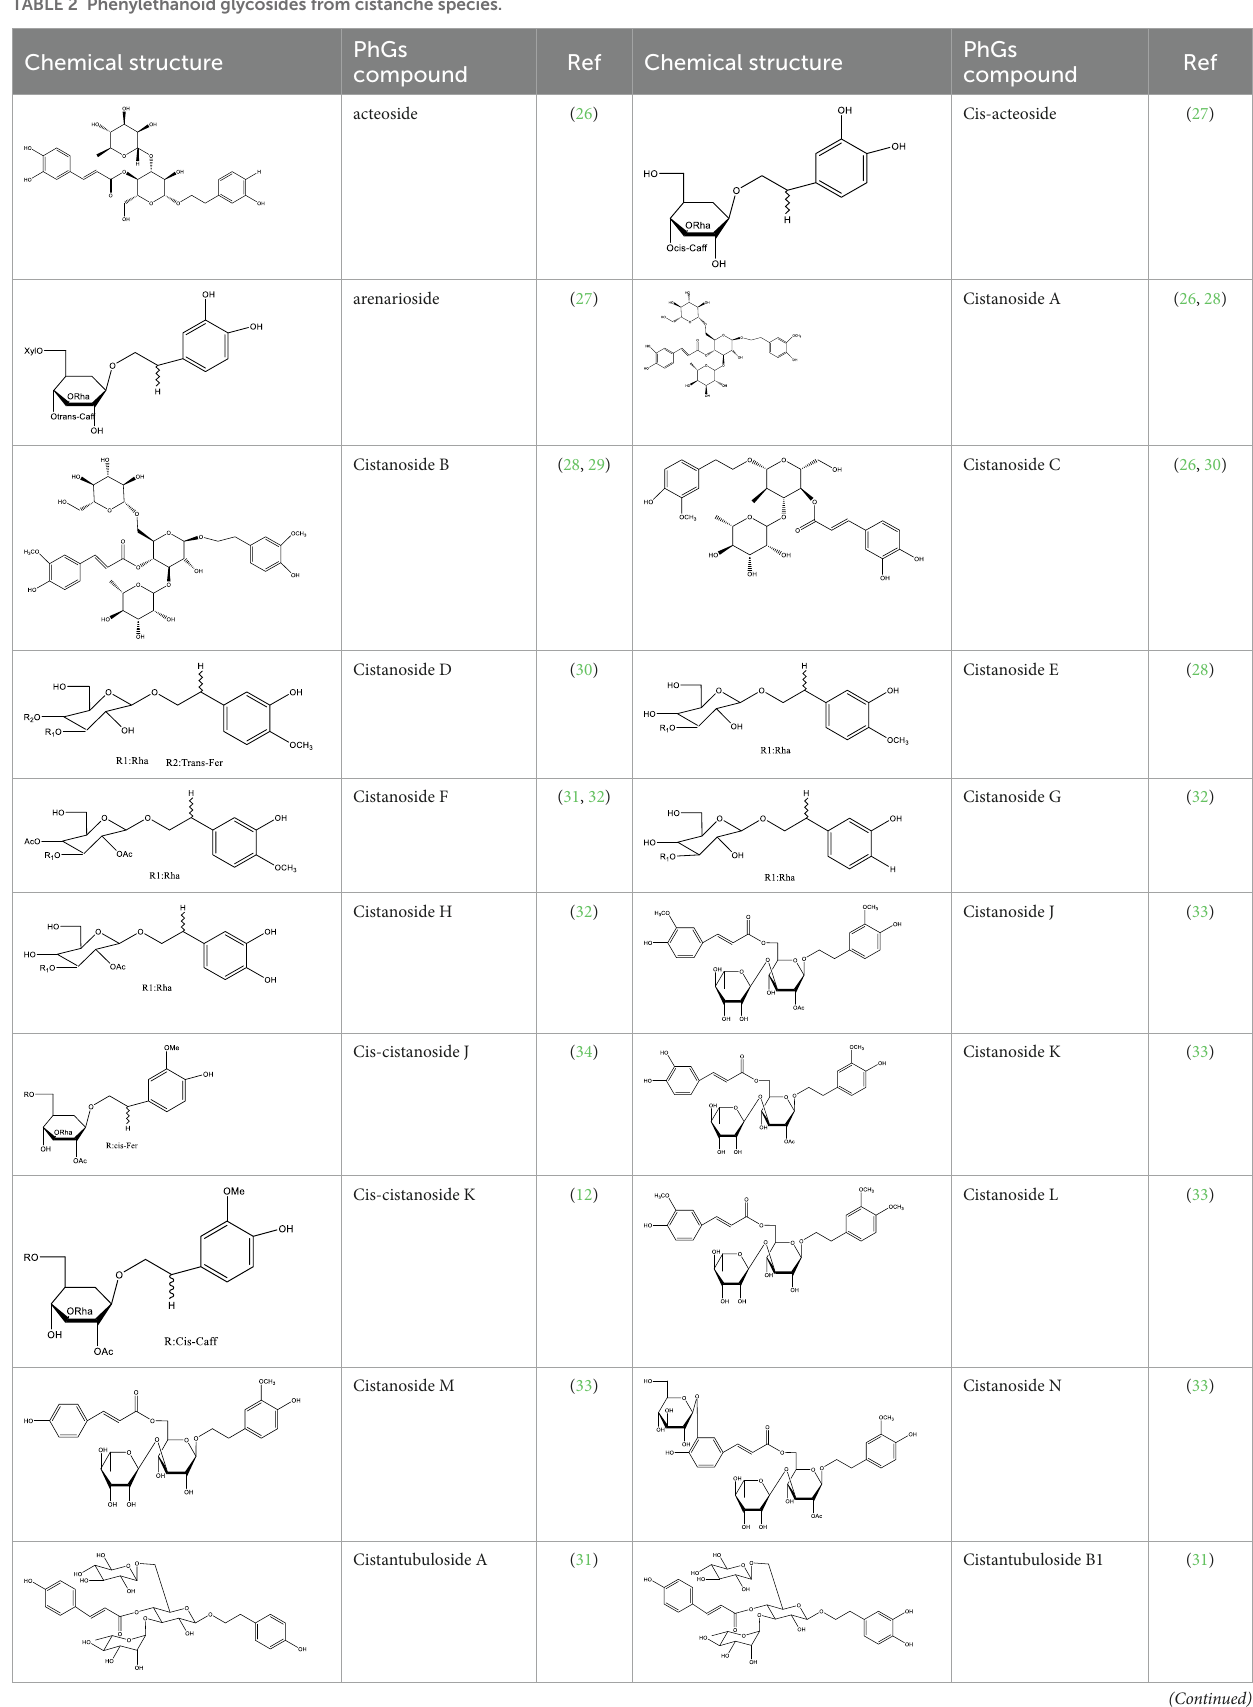
TABLE 2 Phenylethanoid glycosides from cistanche species. Chemical